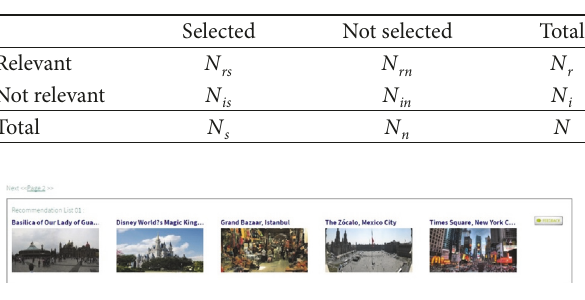
Table 6: Precision and recall matrix.